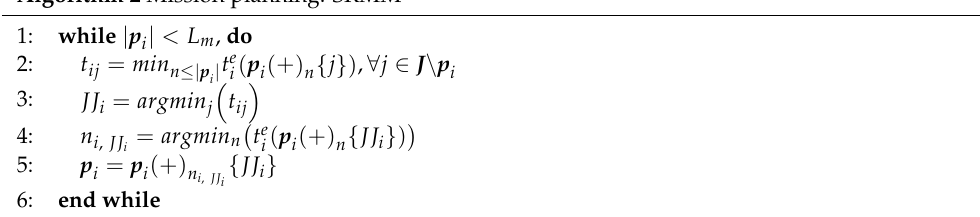
Algorithm 2 Mission planning: SRMM